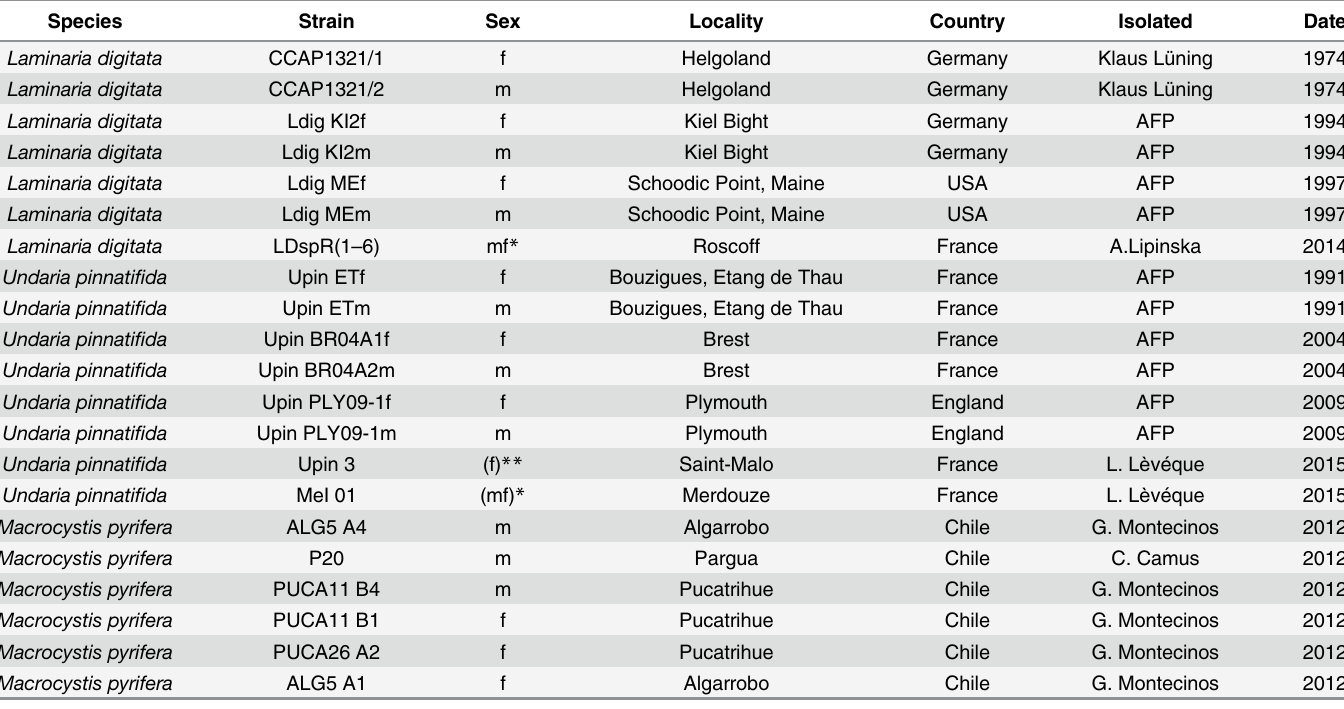
Table 1. Origins of the kelp gametophyte clones used in this study.